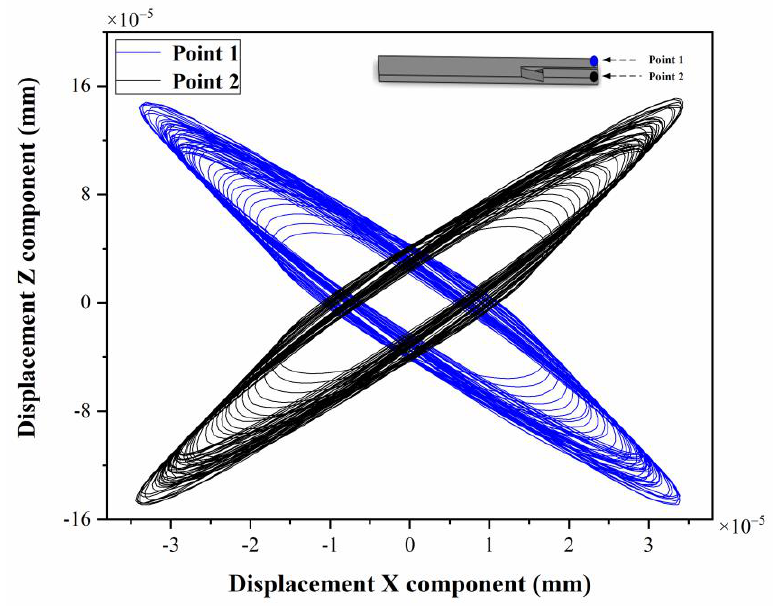
Figure 16. The vibration trajectories of tips.